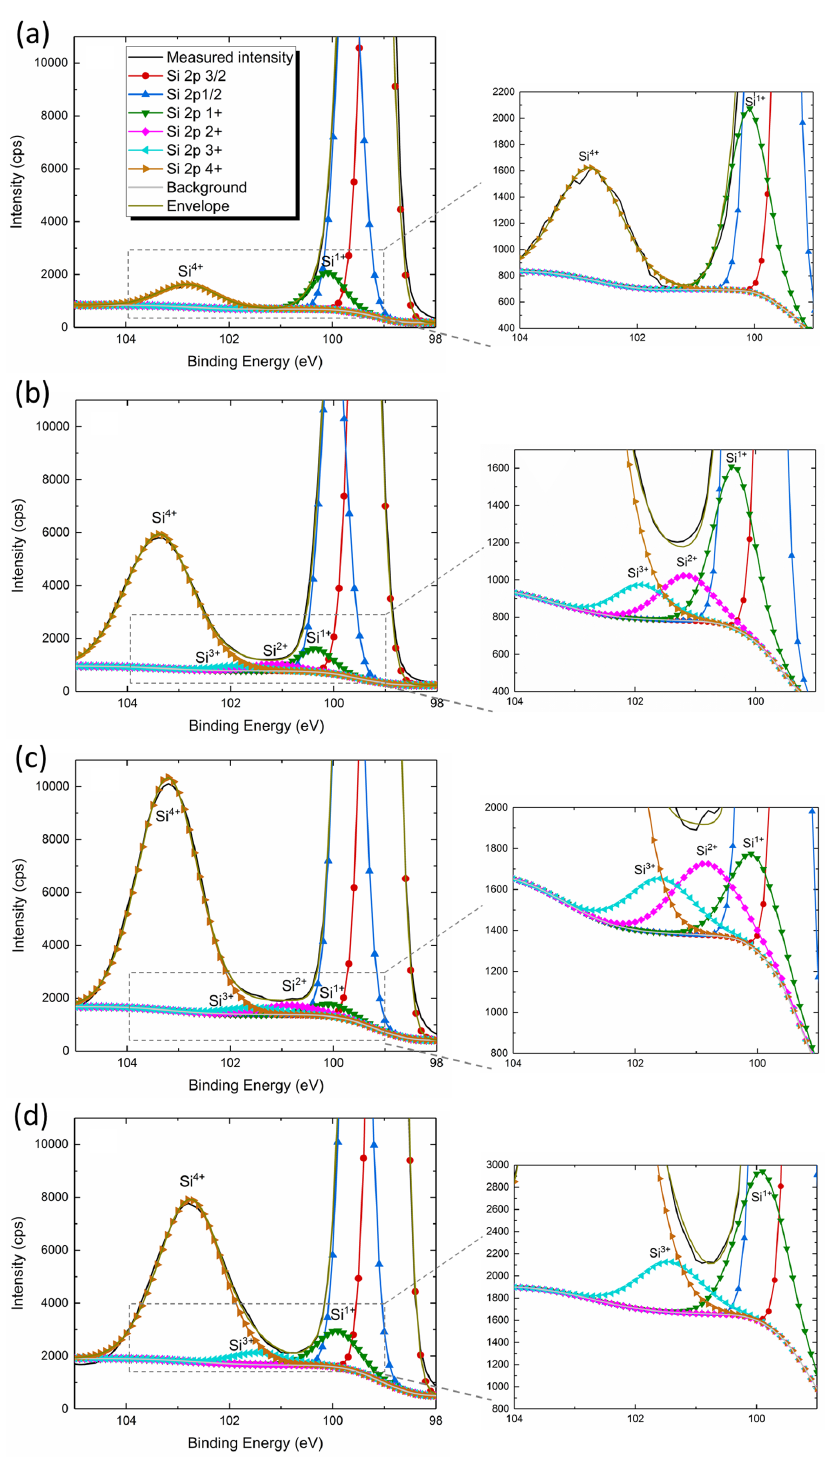
Figure 4. X-ray photoelectron spectroscopy (XPS) spectral decomposition of the Si 2p spectrum showing the sub-oxide peaks for: ( a ) oxide grown by immersion alone; ( b ) FIA oxide anodised at constant voltage of 1.0 V for 20 min; ( c ) thermally-grown thin oxide; and ( d ) wet-chemical oxide grown in HNO 3 . A higher resolution view of the sub-oxide region of the spectrum is also shown for each oxide.